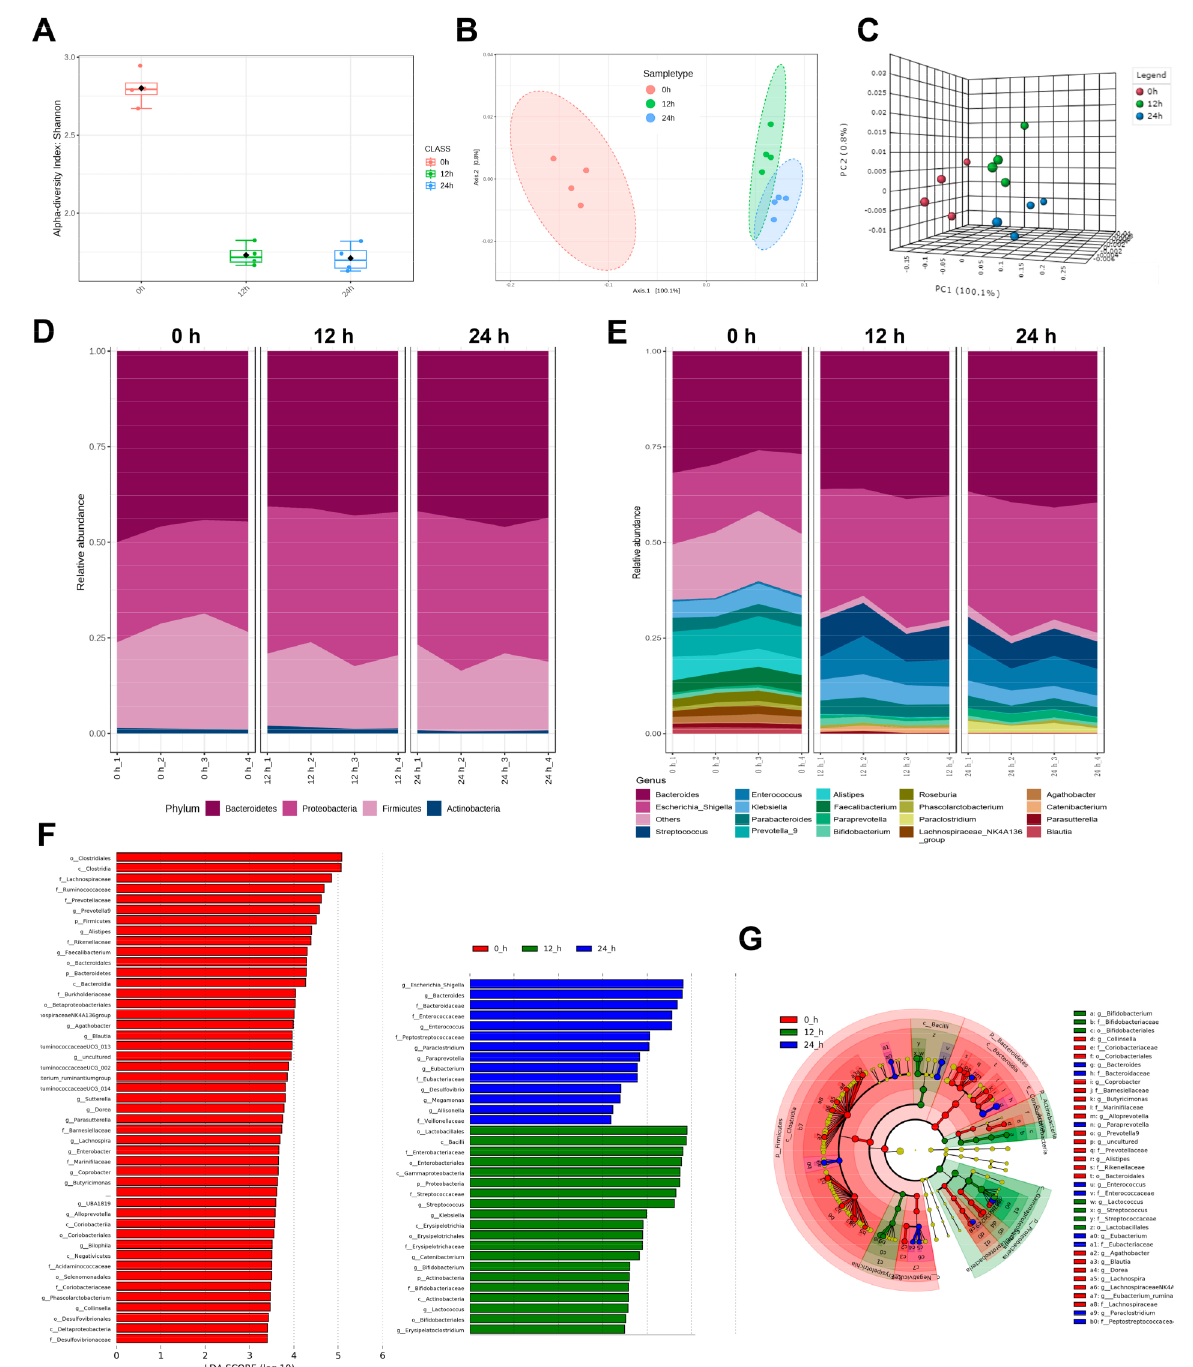
Figure 2. The effects of ABP on the gut microbiota. ( A ) alpha diversity; ( B , C ) beta diversity; ( D , E ) the composition of gut microbiota at phylum and genus levels, respectively; ( F , G ) histograms of LDA scores and circular cladograms, respectively, for statistically significant differences among the 0 h, 12 h and 24 h groups based on the LefSe analysis. p, phylum; c, class; o, order; f, family; g, genus. The diameters of the circles ( G ) are positively related to the relative abundances. Red, green, blue, and yellow circles indicate microorganisms that are significantly enriched in the 0 h, 12 h and 24 h group, or are not significantly affected,